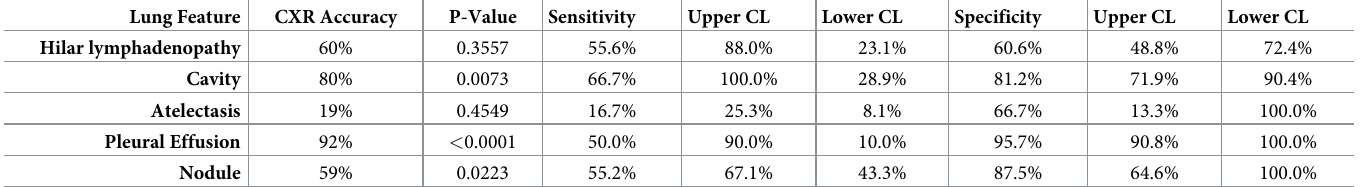
Table 5. 75 TBPP CXR Annotations for Sensitive TB versus Qure.ai Binary Prediction, Crosstabulation Summary Statistics. Lung Feature